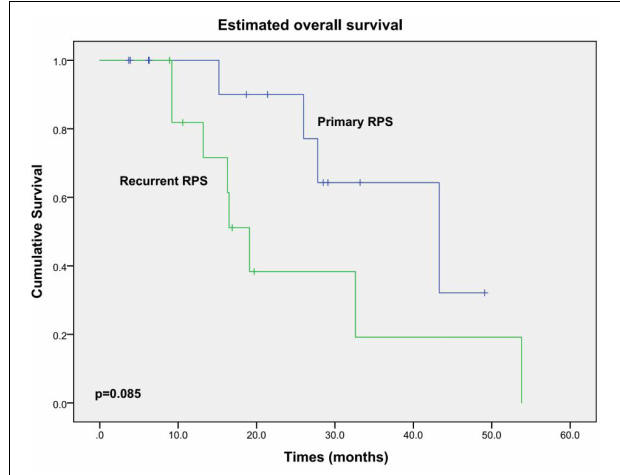
FIGURE 2 | Kaplan–Meier OS estimates for the patients underwent PD during RPS